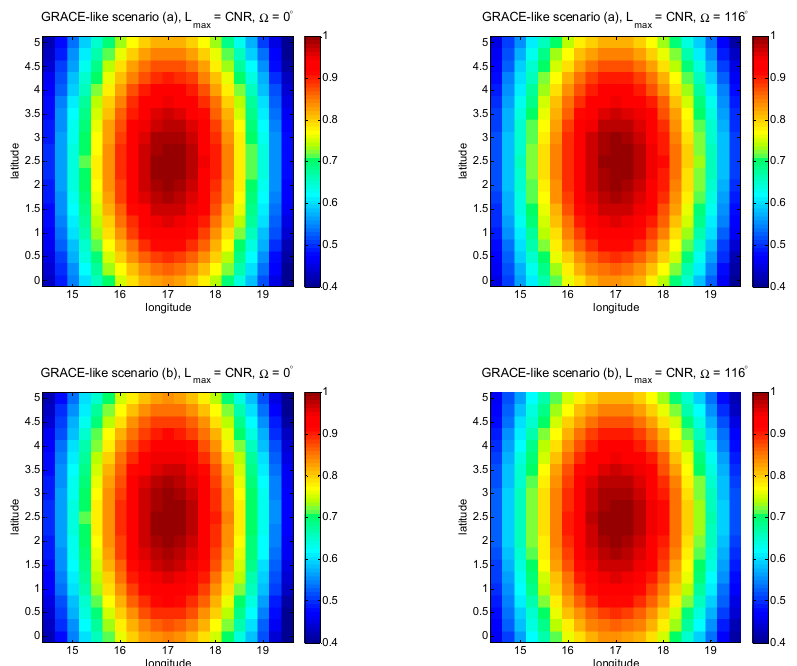
Figure 23. Spatial covariance of a selected point in West Africa (from Figures 19 and 20) for 6-day solution of the inline formation up to L max = CNR, for top : scenario (a), and bottom : scenario (b). Left is Ω = 0 ◦ and right is Ω = 116 ◦